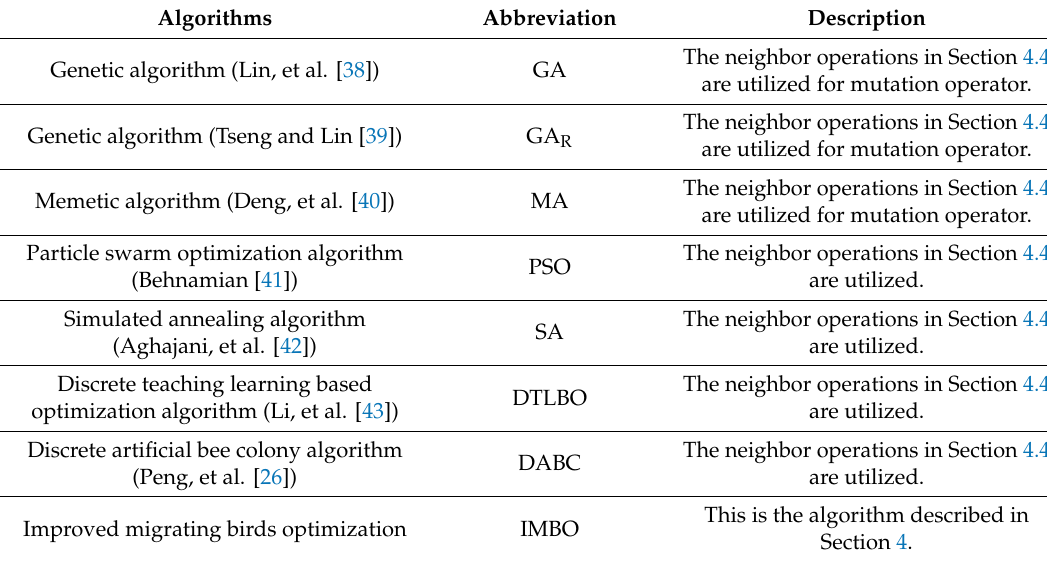
Table 4. Summary of the tested